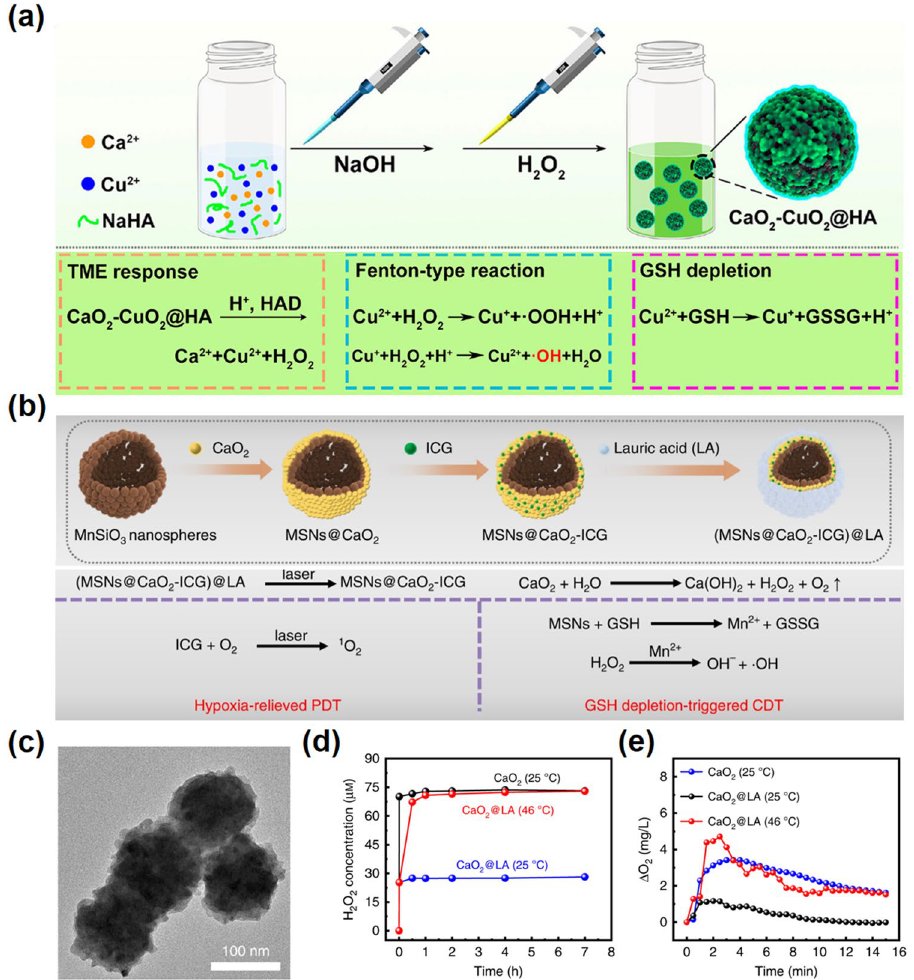
Fig. 5 Calcium peroxide-based nanomaterials. a Synthesis procedure (top panel) and antitumor performance (low panel) of CaO 2 − CuO 2 @HA NPs [72]. Copyright 2022, American Chemical Society. b Schematic illustration of the synthesis (top panel) and therapeutic mechanism (low panel) of (MSNs@CaO 2 -ICG) @LA NPs. c TEM images of MSNs@CaO 2 . d H 2 O 2 cumulative release profile and e O 2 generation in PBS [79]. Copyright 2022, Springer